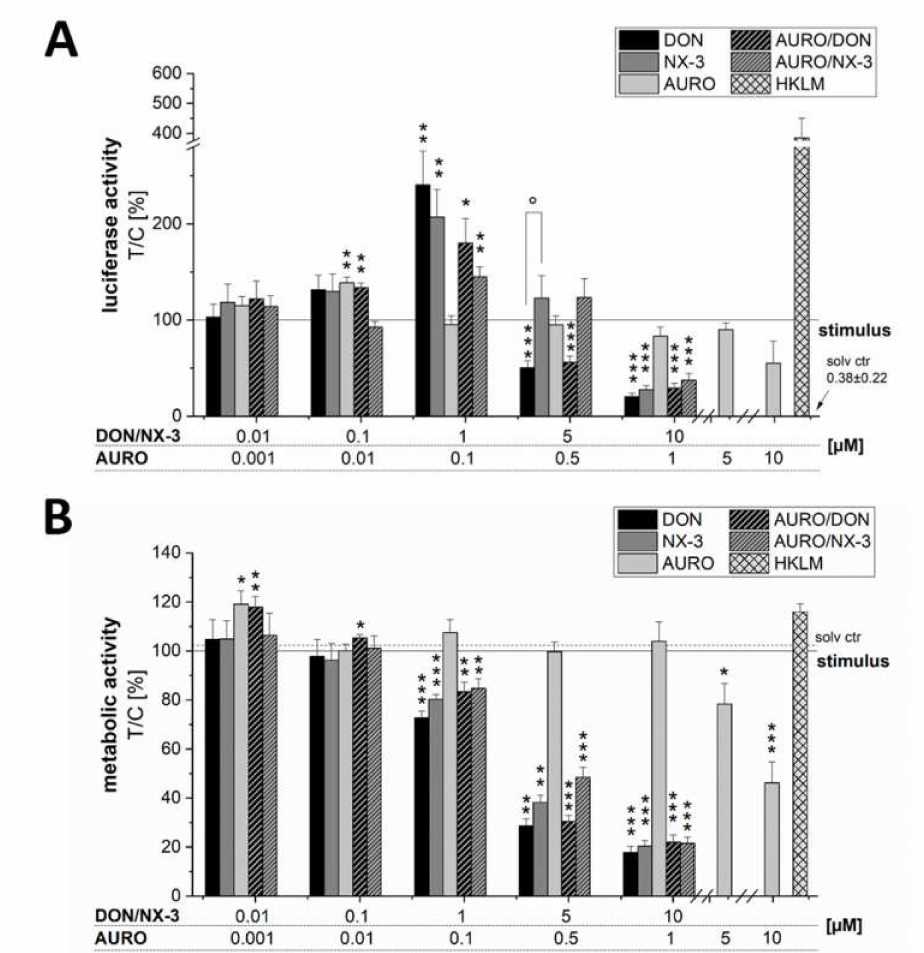
Figure 2. Activity of nuclear factor kappa B (NF- κ B) in ( A ) lipopolysaccharide (LPS)-stimulated human monocytic THP1-Lucia ™ NF κ B cells. THP1-Lucia NF- κ B cells were preincubated with the compounds (DON, NX-3, AURO and their combinations) for 2 h followed by an 18 h LPS challenge (10 ng / mL). Heat-killed Listeria monocytogenes (HKLM; 20 × 10 6 cells / well) served as positive control for Toll-like receptor-mediated activation of the NF- κ B pathway. Luminescence intensity data are expressed as mean values ± SE normalized to LPS-treated solvent control and to the respective cell viability data, assessed in ( B ) the alamarBlue ® cell viability assay of at least five independent experiments. One percent DMSO and 1% water (LC–MS grade) served as solvent control (dotted line). Significant di ff erences to